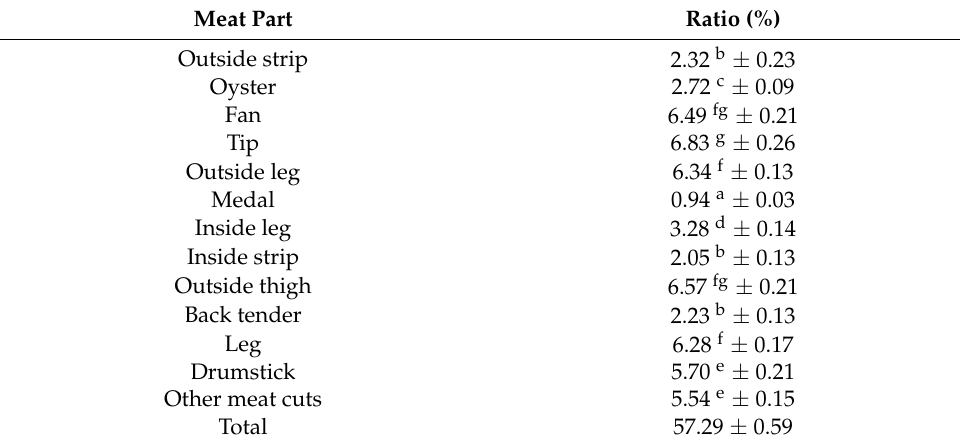
Table 2. Percentage of individual valuable meat parts ( n =